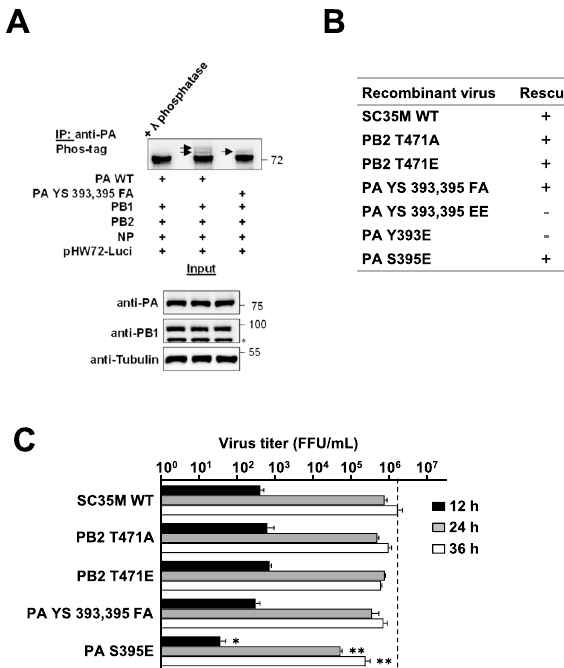
Figure 2. The effects of PB2 and PA phosphorylation on viral replication. ( A ) 293T cells were transfected with pCAGGS vectors directing the synthesis of the four proteins forming the vRNP together with the plasmid pHW72-Luci expressing a Pol1 promoter-driven vRNA-like transcript. One fraction of the extracts was analyzed by SDS-PAGE and immunoblotting for correct expression of the transfected proteins (Input). The remaining material was used for immunoprecipitation and treatment with λ phosphatase as a control, followed by Phos- tag™ SDS-PAGE and detection of PA phosphorylation, as revealed by occurrence of upshifted bands which are indicated by arrows. The position and size (kDa) of molecular weight markers are shown. ( B ) Summary of the rescue of recombinant viruses encoding the indicated WT and mutant proteins, a + indicates successful rescue. ( C ) MLE-15 cells were infected with the indicated viruses at a MOI of 0.001 and viral growth was monitored 12, 24, and 36 h.p.i. by focus forming assays. Focus forming units (FFU) are shown, the dashed line represents the peak of WT SC35M titers. Error bars represent SDs from three independent experiments. All P values show significance in comparison to the WT control at each time point using one-way ANOVA (* P ≤ 0.05 and ** P ≤